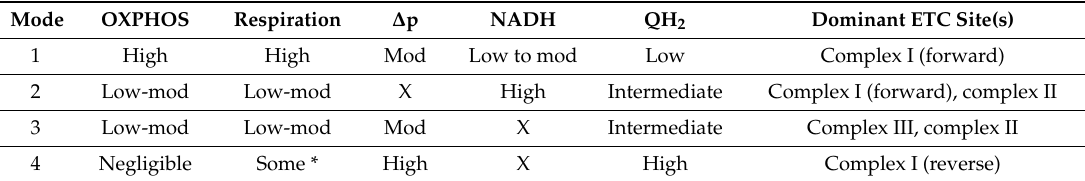
Table 2. Summary of the main modes of mitochondrial ROS production. The dominate electron transport chain site is listed for each mode. The site may vary according the prevailing conditions. In practice, when one considers Table 1, other sites will also operate depending on the substrates being oxidized (e.g., pyruvate dehydrogenase (PDH) in mode 2). X denotes that a given variable has no known appreciable role in governing the